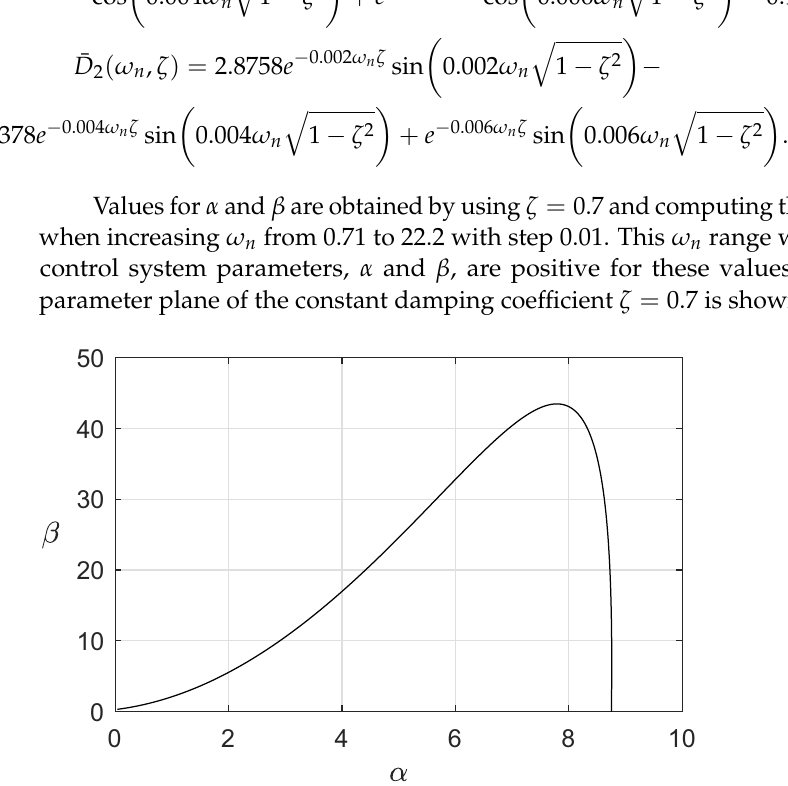
Figure 2. The loci in the αβ parameter plane of the constant damping coefficient ζ =